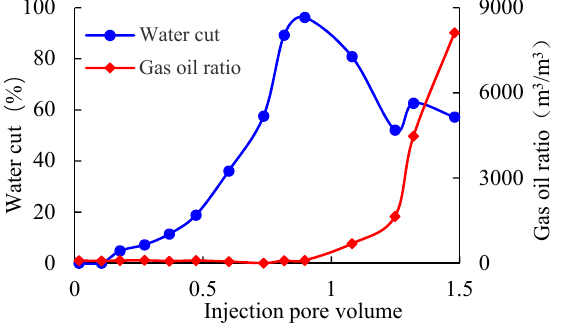
Figure 13. The relationship between injected pore volume and water cut, gas–oil ratio (0.98 mD core).